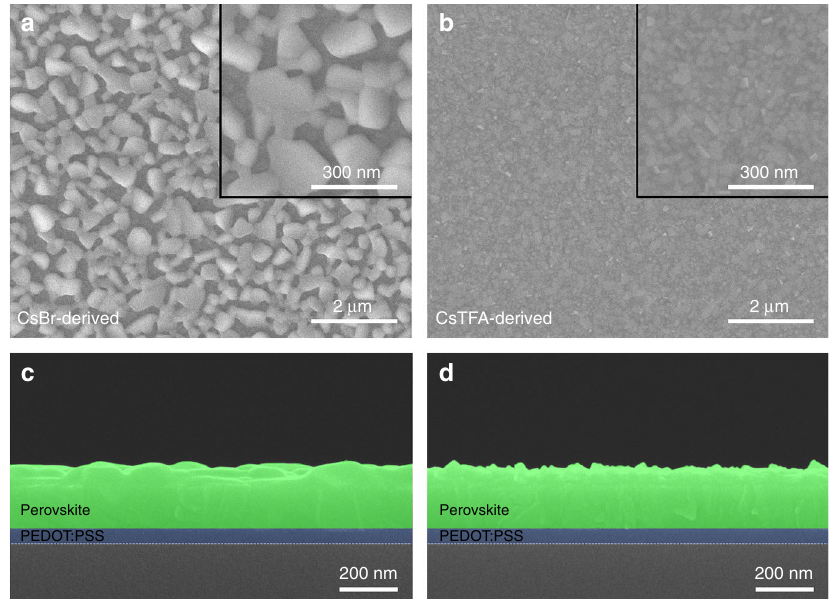
Fig. 2 Morphologies of the CsBr- and CsTFA-derived CsPbBr 3 perovskite fi lms. Top-view a , b and cross-sectional view c , d FE-SEM images of CsPbBr 3 perovskite fi lms deposited on ITO/PEDOT:PSS substrates from a , c CsBr(1.7) and b , d CsTFA(1.7) precursor solutions. Insets in a and b show high magni fi cation top-view images of the respective fi